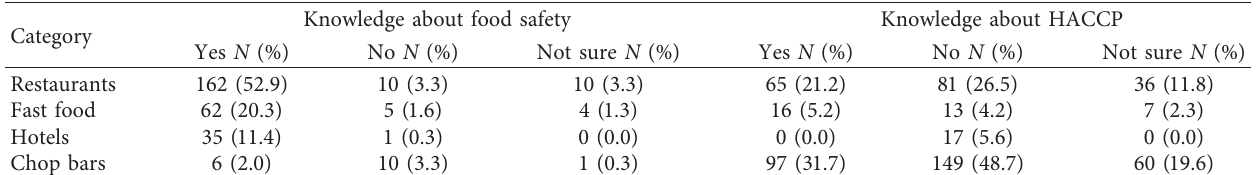
Table 2: Respondents knowledge of food safety and